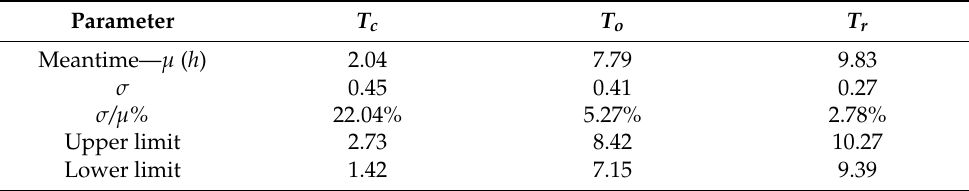
Table 2. The recovery times’ mean